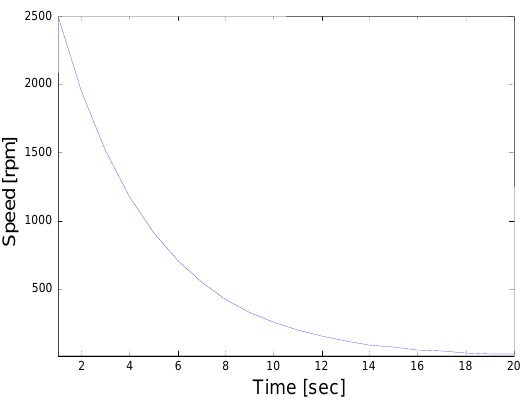
Figure 10. Experimental coast-down